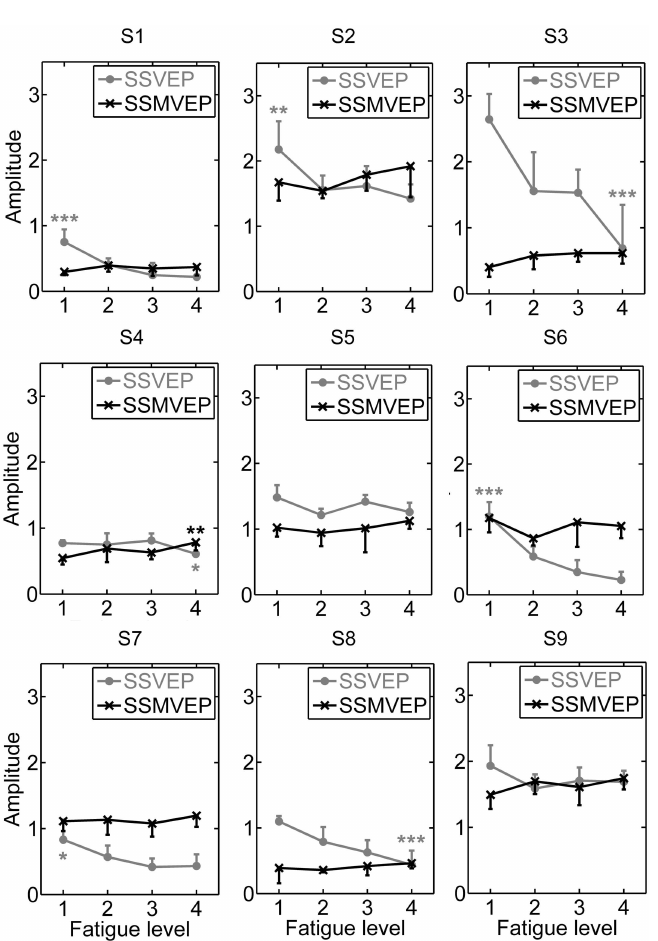
Fig 4. Comparison of SSVEP and SSMVEP amplitudes between four different fatigue levels for individual subjects. All statistics were assessed by one-way ANOVA, *** p < 0.001 between four different fatigue levels in both of SSVEP-BCI and SSMVEP-BCI tasks, ** p < 0.01 between four different fatigue levels, * p < 0.05 between four different fatigue